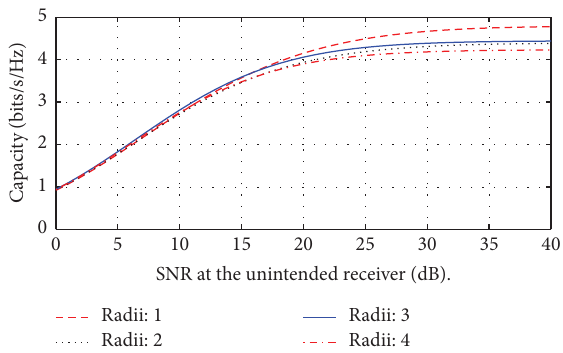
Figure 25: Capacity comparison: average outcome. Te radius values are wavelength